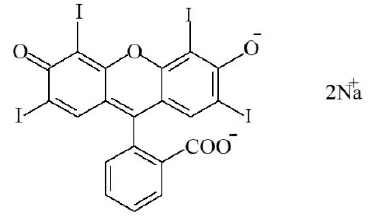
Figure 21. Erythrosine dye’s structural formula